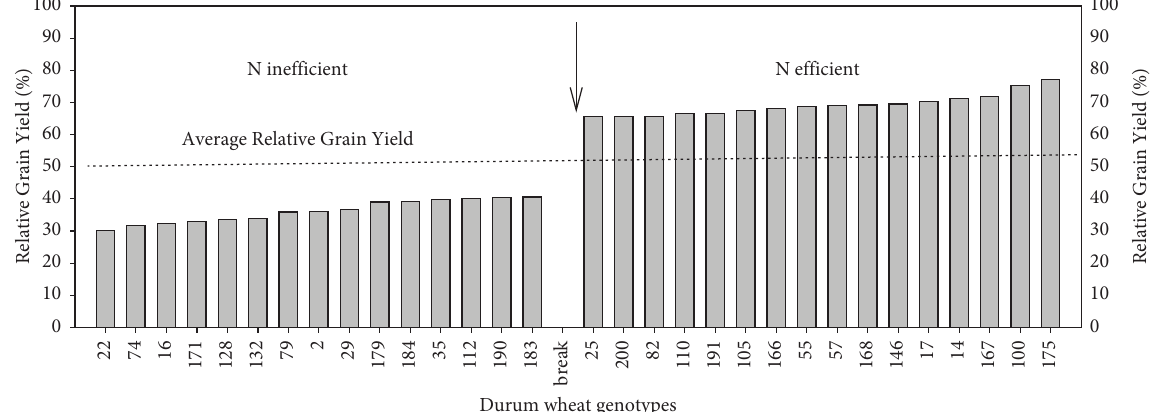
Figure 2: Categorization of N-efcient and inefcient genotypes based on relative grain yield (only the 15 most extreme genotypes from each efcient and inefcient category were mentioned in the abovementioned fgure due to limited space to accommodate all; the break is the demarcation between N-efcient and inefcient